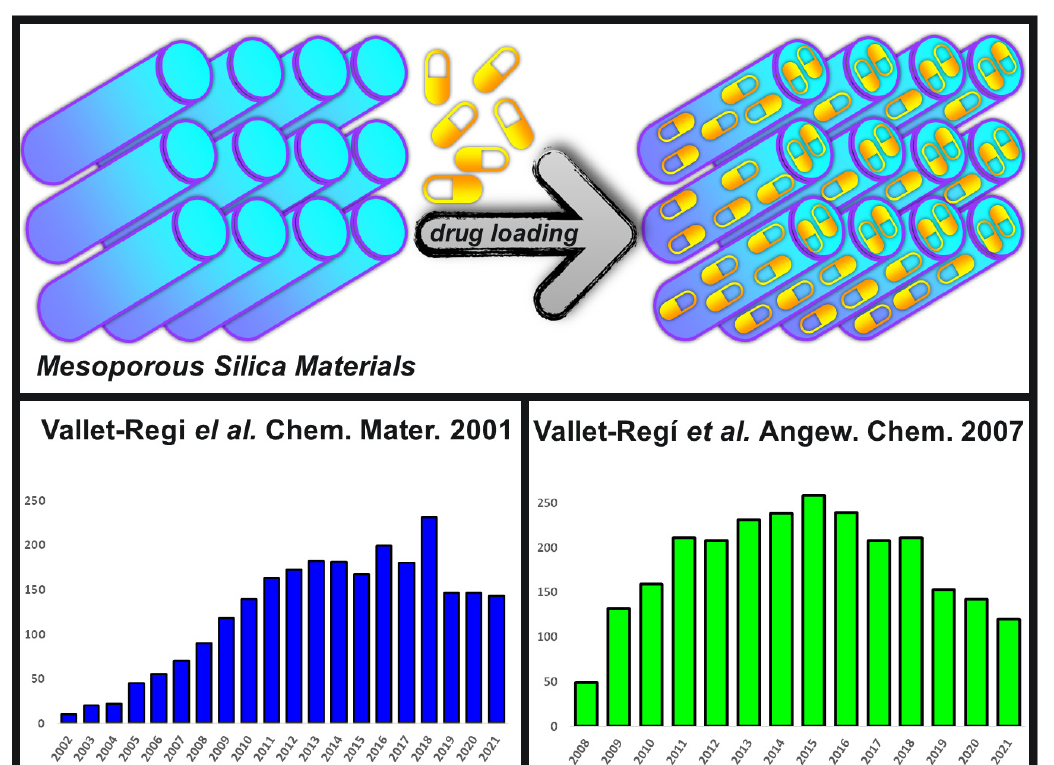
Figure 1. Top: Schematic representation of the original idea of loading drugs into the network of pores of mesoporous silica materials. Bottom left corner: Cites distribution along the last 20 years of the original communication where MSMs were presented as drug delivery systems, adapted from [9], published by American Chemical Society, 2001. Bottom right corner: Cites distribution of one of the most important reviews on this topic reported on Angewandte Chemie after only 6 years of the original research paper, adapted from [10], published by Wiley-VCH, 2007.